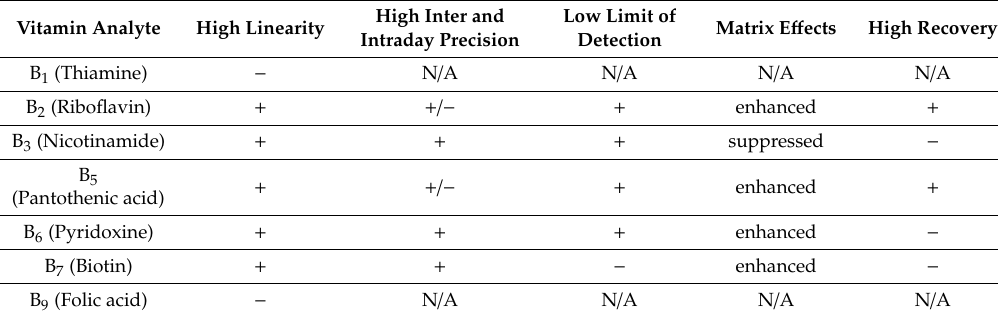
Table 5. Summary of B vitamin analysis of HPLC–MS / MS